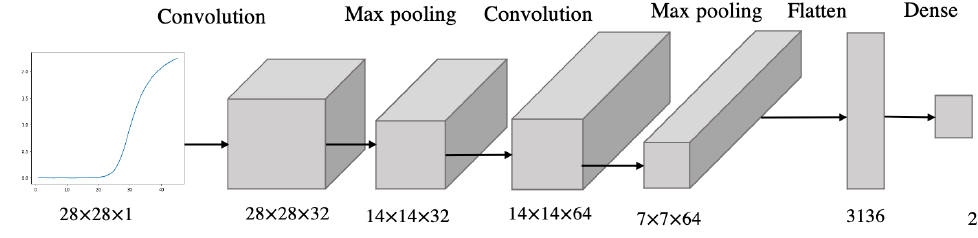
Figure 8. Architecture of the CNN